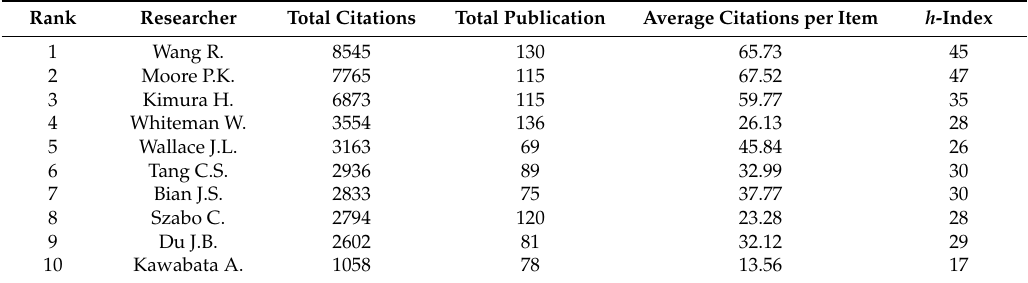
Table 3. The top 10 most cited authors in H 2 SBM research.